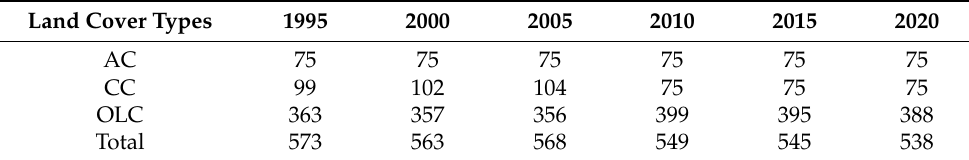
Table 1. The number of random ground reference data of Abandoned Cropland (AC), Cultivated Cropland (CC) and Other Land-Covers (OLC) for study areas in 1995, 2000, 2005, 2010, 2015 and